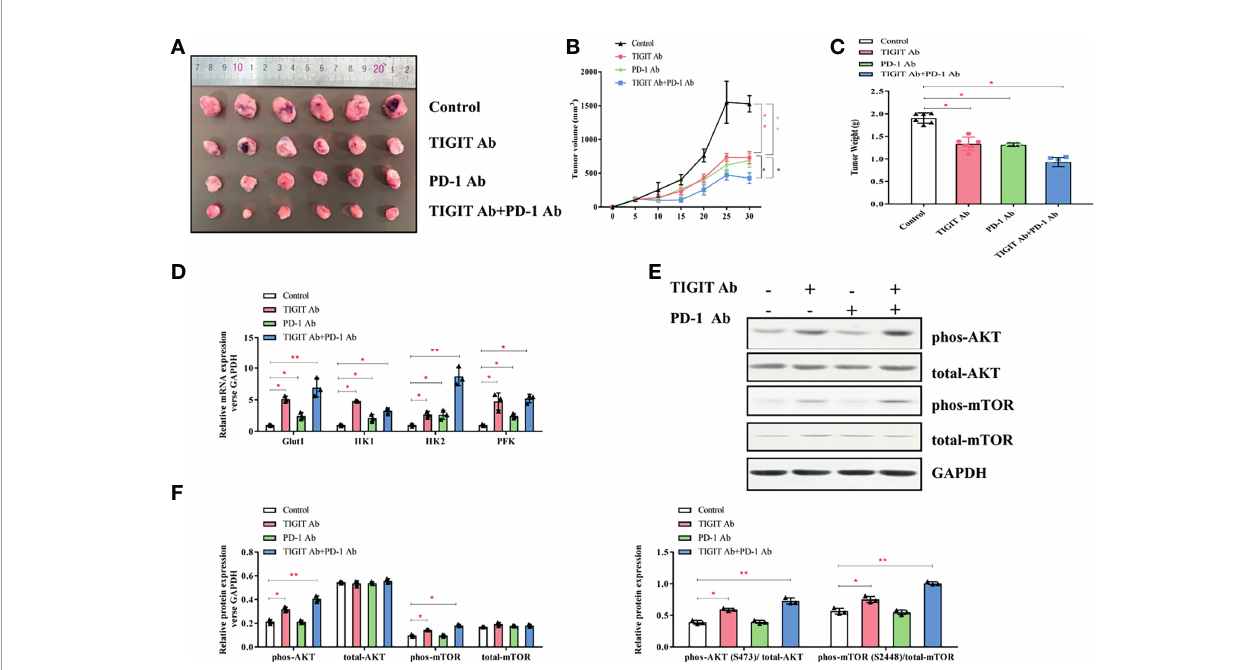
FIGURE 7 | Impact of TIGIT and/or PD-1 antibody on tumor growth in vivo . (A) Tumors were removed and collected from B6J mice injected with TIGIT and/or PD-1 antibody. (B) The tumor volume was analyzed every 5 days. (C) The tumor weight was measured 30 days after tumor transplantation. (D) RT-PCR was applied to quantify the mRNA levels of Glut1, HK1, HK2, PFK, and GAPDH. (E) Representative blots of each group. (F) , Western blotting analysis was performed to determine the expression of phos-AKT, total-AKT, phos-mTOR, total-mTOR. * P < 0.05; ** P <